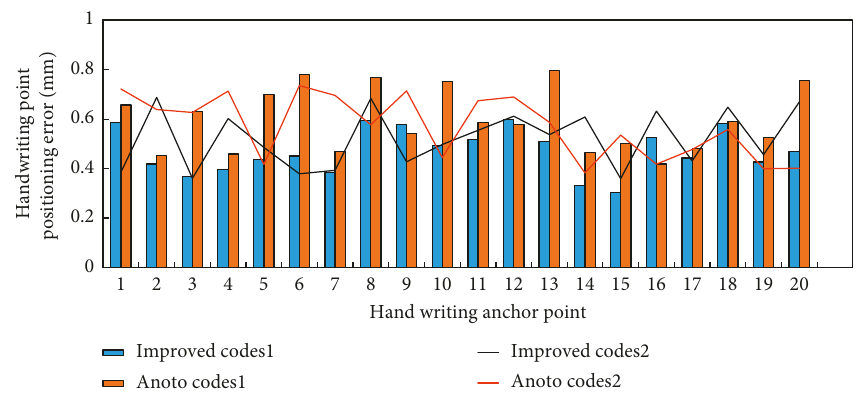
Figure 4: Two groups of studies.